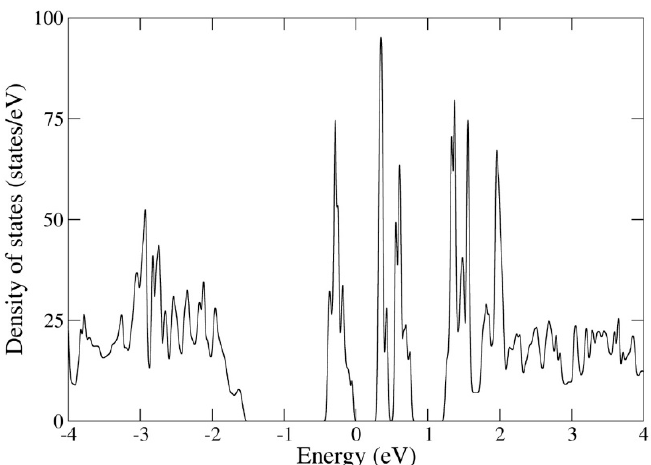
Figure 1. Calculated total unit-cell electronic density of states (states / eV) for UI 3 . The energy scale on the x-axis is shifted so that the highest occupied level is located at zero energy.